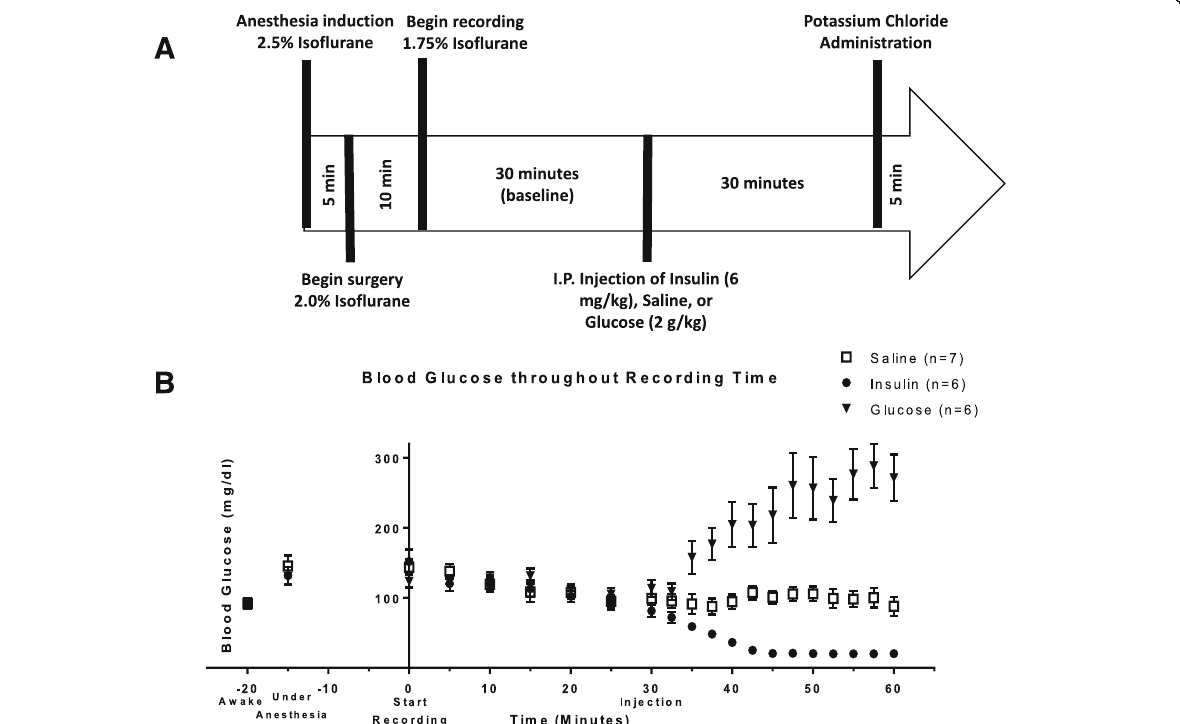
Fig. 1 Recording Neural Events in Acute Hyper and Hypoglycemia. a Mice are anesthetized with isoflurane, the nerve is fitted with a bipolar, cuff electrode from Cortec and activity is recorded using a Plexon acquisition system. After 30min ’ baseline recording, mice received 6mg/kg insulin, 2g/kg glucose, or saline, and were recorded for an additional 30min. b Blood glucose was measured via tail nick with glucometer throughout the recording. Blood glucose dropped significantly in mice that received insulin within 10min. Blood glucose rose significantly in mice that received glucose